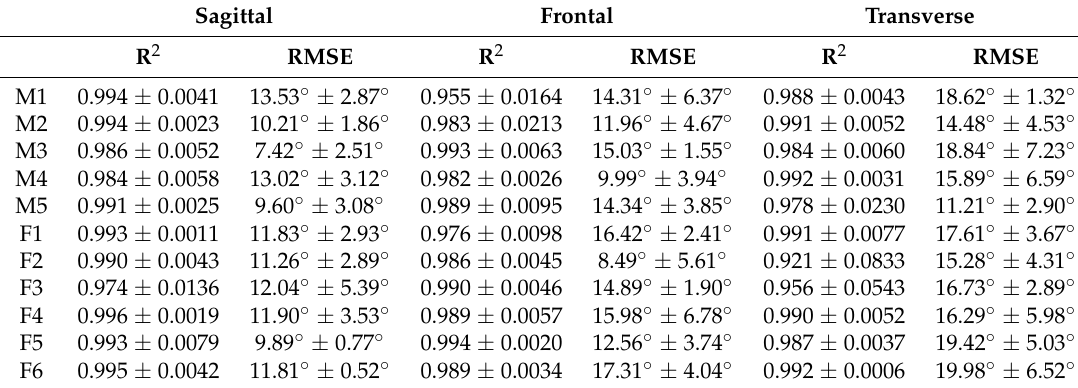
Table 3. RMSE and correlation coefficient for Cameras and IMU.